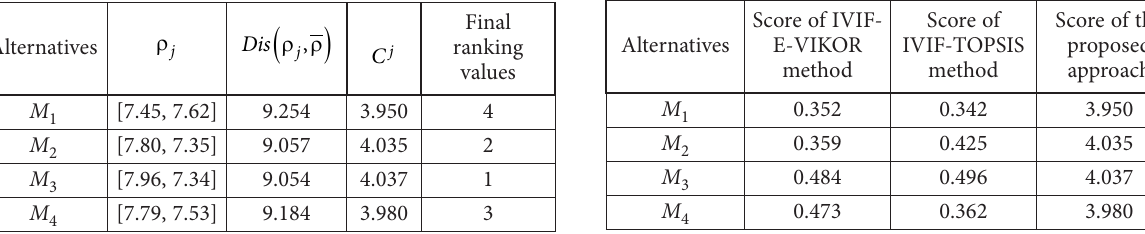
Table 10. Comparing the score values among three IVIF